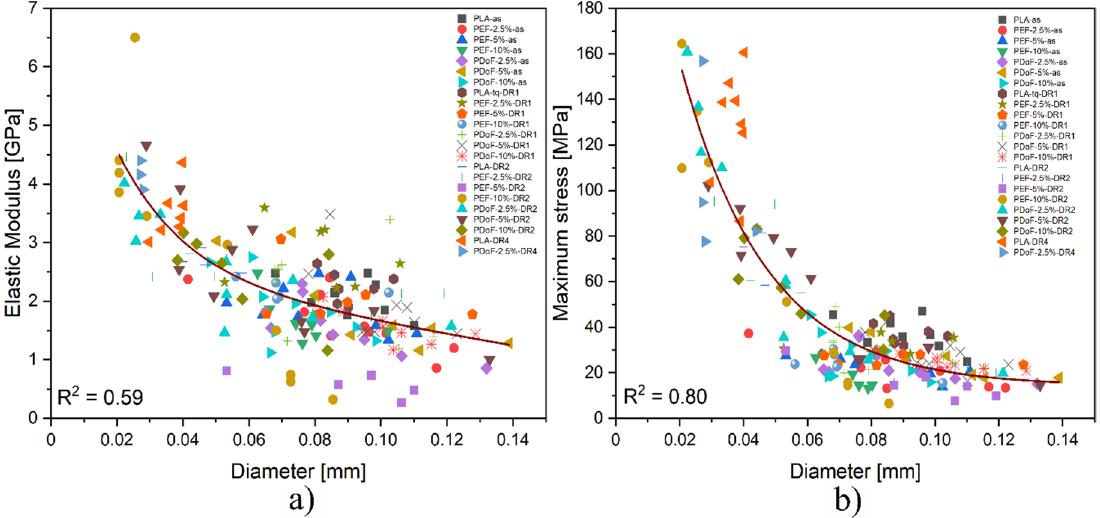
Figure 12. Trend of the ( a ) elastic modulus, and ( b ) maximum stress as a function of the diameter of all the prepared fibers.